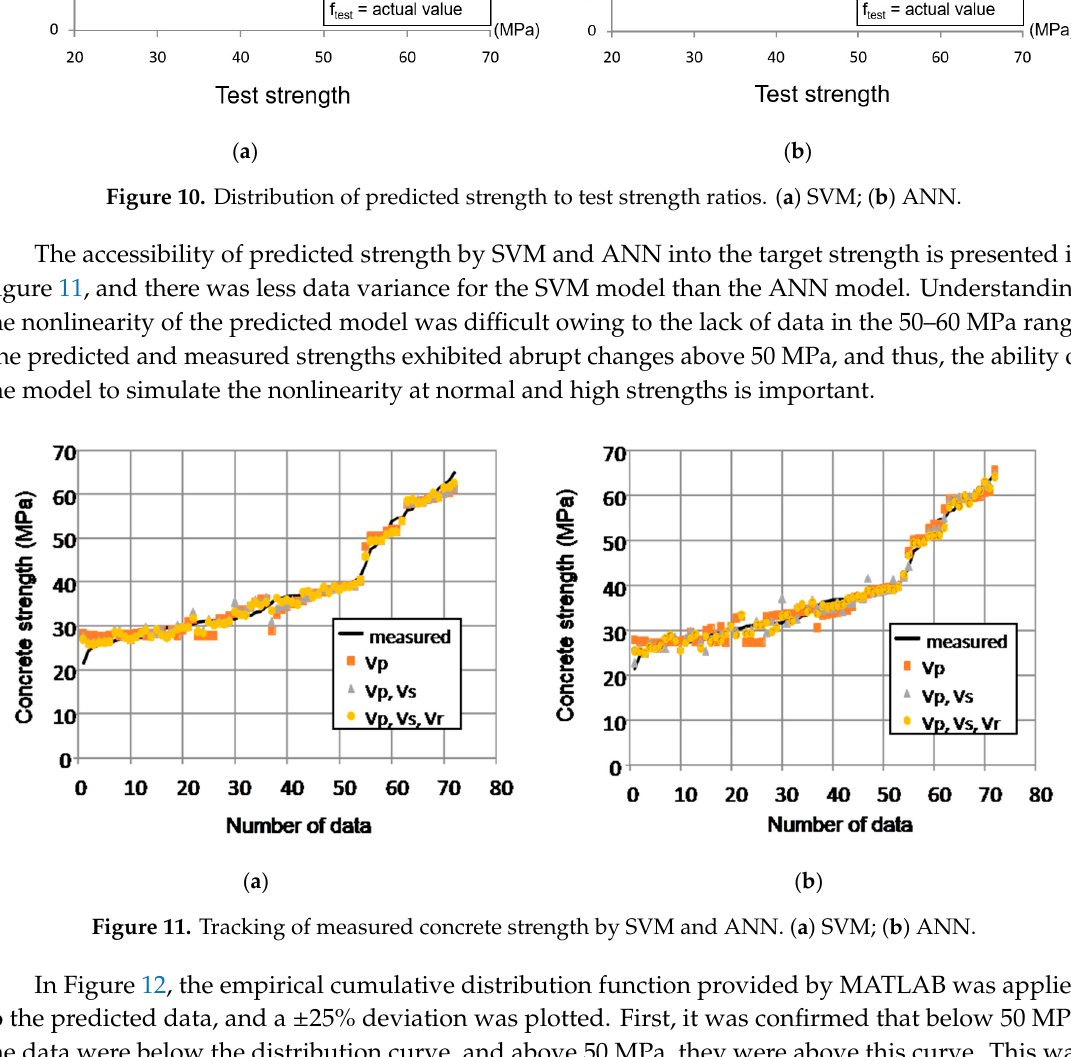
Figure 10. Distribution of predicted strength to test strength ratios. ( a ) SVM; ( b ) ANN.